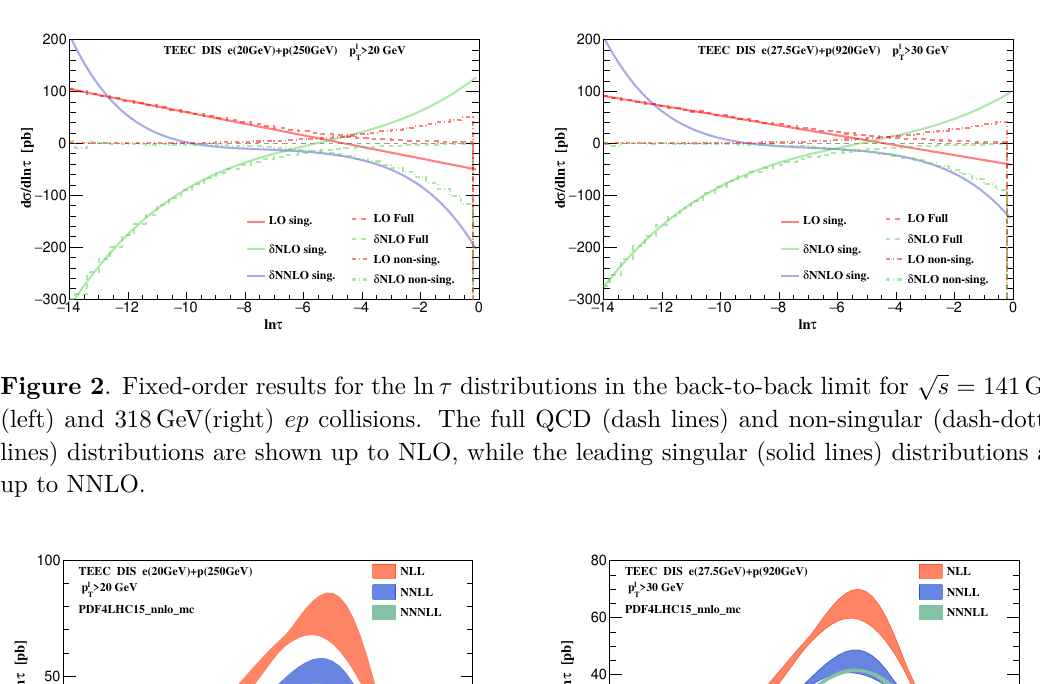
Figure 3 . Resummed distributions in the back-to-back limit. The orange, blue, and green bands are the predictions with scale uncertainties at NLL, NNLL and N 3 LL, respectively. Left and right panels are for EIC and HERA energies,